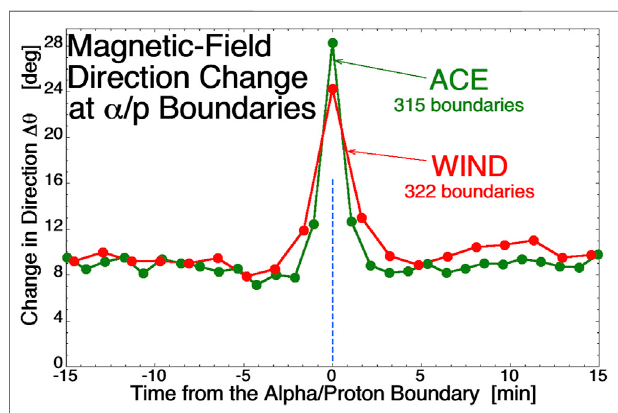
FIGURE 2 | Superposed epoch averages of change in the direction of the solar-wind magnetic fi eld with the zero epoch being an ion-composition boundary as identi fi ed by a sudden change in the α / p value. The green curve plots the 64-s change in the fi eld direction for 315 α /p boundaries identi fi ed with the ACE spacecraft and the red curve plots the 97-s change in the fi eld direction 322 for α /p boundaries identi fi ed with the WIND